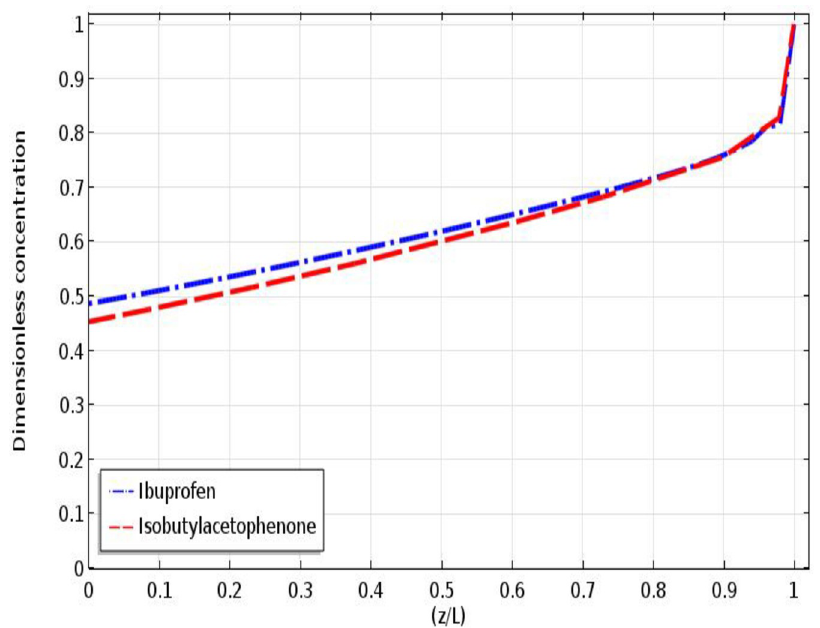
Fig 5. Axial dimensionless concentration profile of IP and 4-IBAP solutes along the membrane—shell interface.